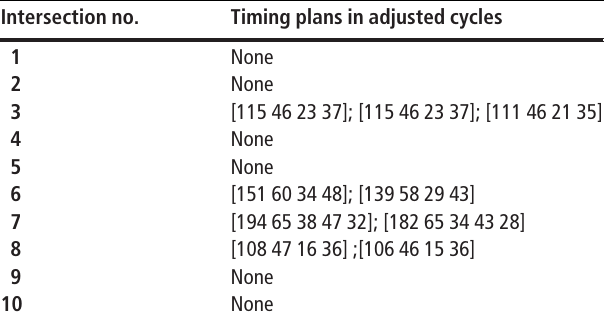
Figure 5 Saturation degree deviations of the fi ve